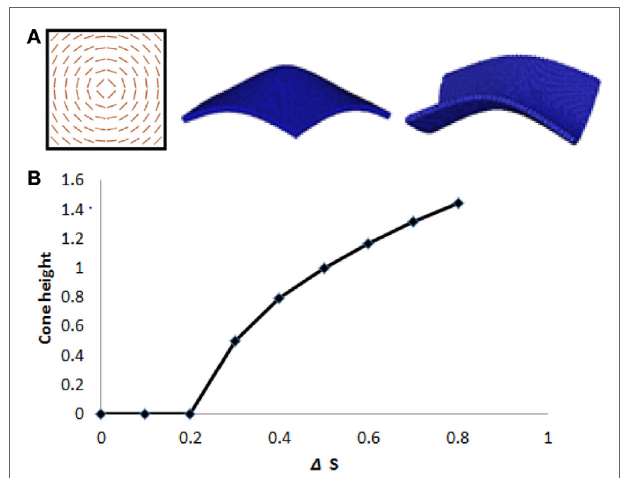
FigUre 1 | (a) Finite element simulations – LCE with an azimuthal + 1 defect, and aspect ratio 50:1, deforms into a cone on heating and an anticone (saddle) on cooling. (B) Cone height as a function of Δ S , the reduction of nematic scalar order parameter on heating. The sample initially remains flat on heating, in a metastable state. The cone emerges only when heated sufficiently that Δ S > 0.2.